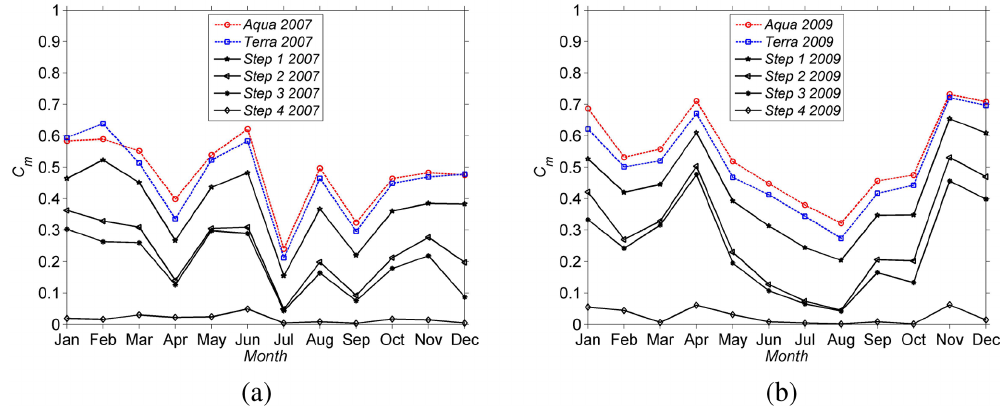
Figure 7. C m , average monthly values of C d remaining after the implementation of each step for year 2007 (a) and 2009 (b) .